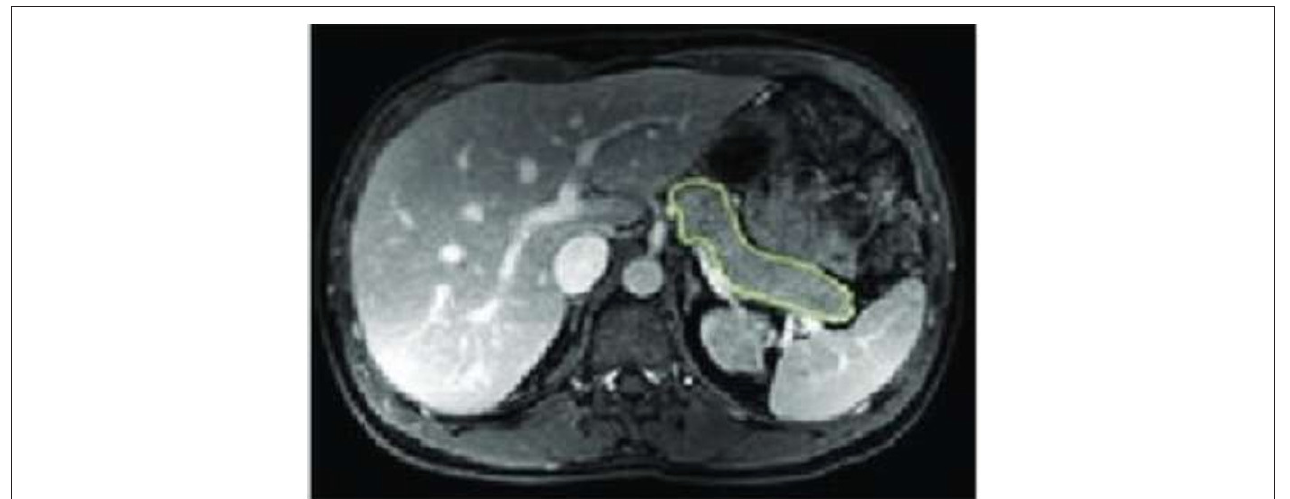
FIGURE 1 | Abdominal MRI showing pancreatic size drawn by hand in the transaxial plane.